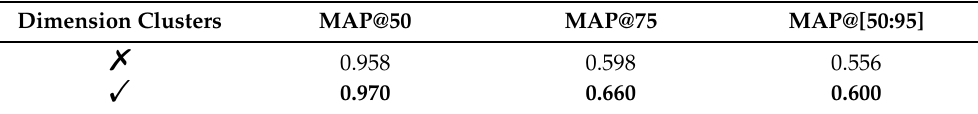
Table 7. Detection performance of multi-scale Faster-RCNN with and without dimension clusters. Dimension